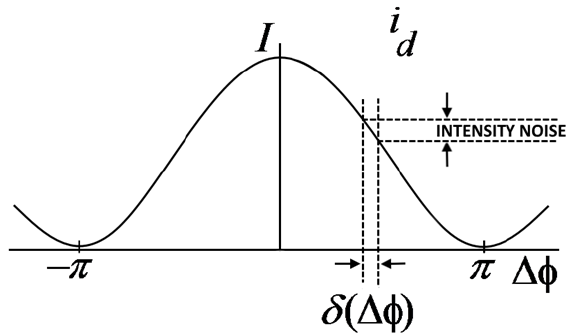
Figure 8. Intensity I of the output photo-current of the photo-detector.